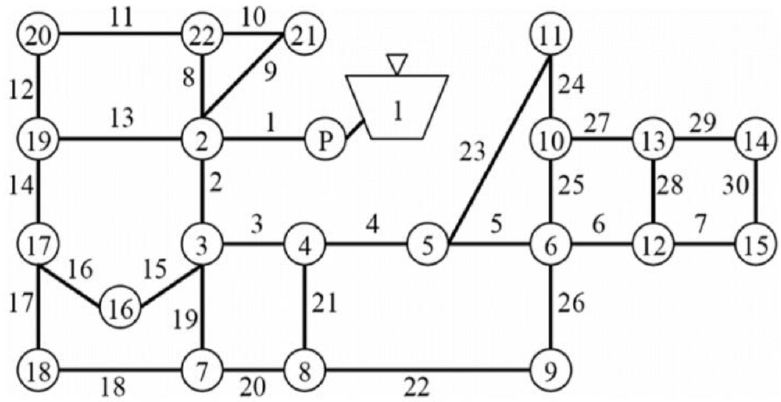
Figure 12. The GoYang network